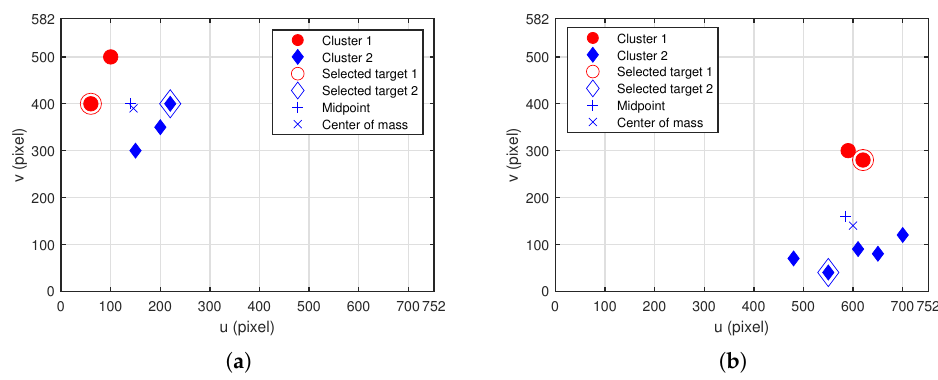
Figure 5. Target selection results of case 1 ( a ) and case 2 ( b ).